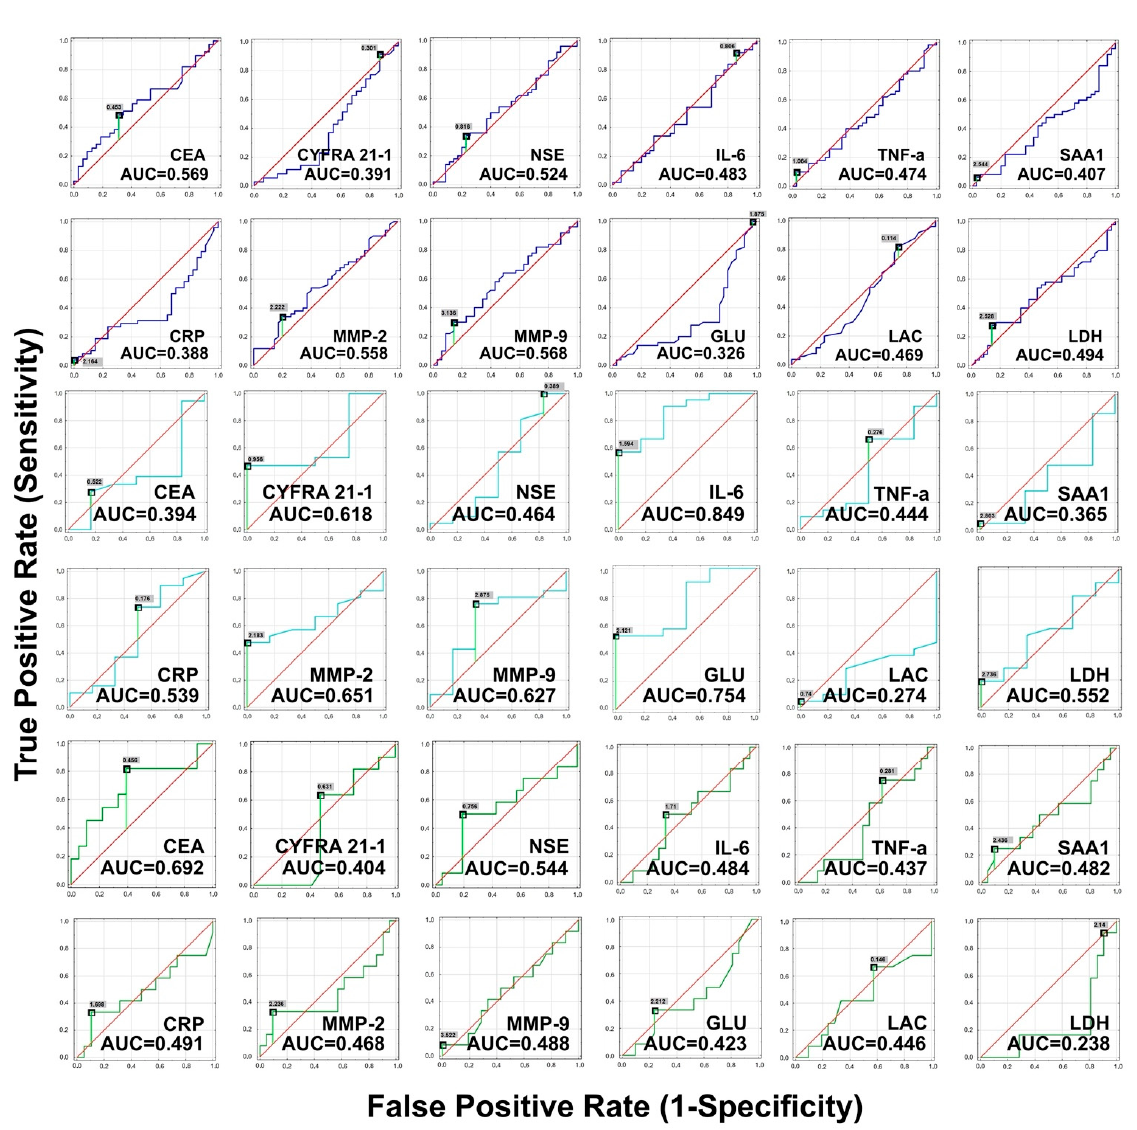
Figure 6. Receiver operating characteristic (ROC) curves evaluating the ability of single biomarkers to distinguish NSCLC patients with adenocarcinoma and squamous cell carcinoma (navy line), lung cancer stage IIB and IIA (teal line), and IIIA and IIB (green line). Table 10. The diagnostic efficiency of multi-biomarker models to distinguish NSCLC patients with adenocarcinoma from patients with squamous cell carcinoma.